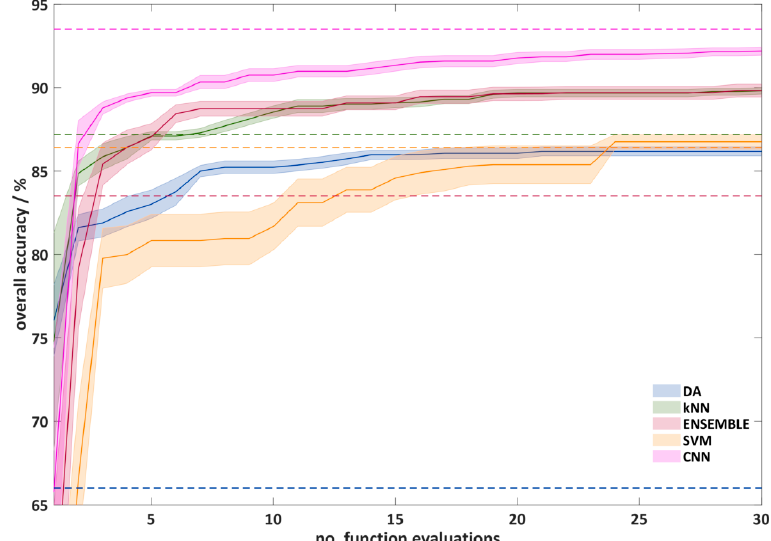
Figure 6. The overall cross-validation accuracy of the outer loop as a function of the number of function evaluation in automatic hyperparameter optimization using random search (RS) optimization. For a better overview, only a quarter of the standard deviation is shown. The dashed lines show the overall classification accuracy with the standard hyperparameter.